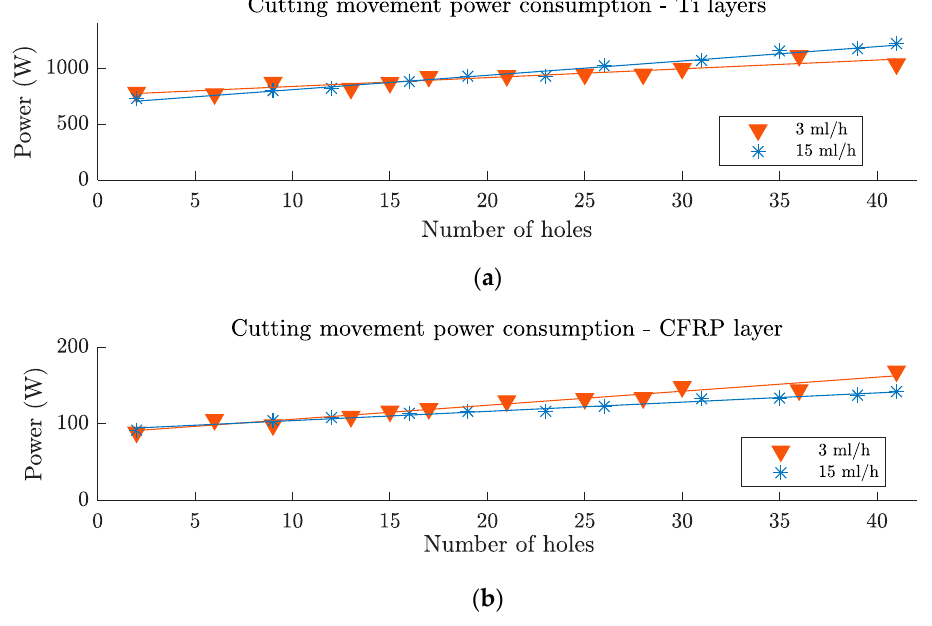
Figure 13. Spindle power consumption, after 40 holes, for a Ti/CFRP/Ti stack on ( a ) the Ti layers and ( b ) on the CFRP layer.